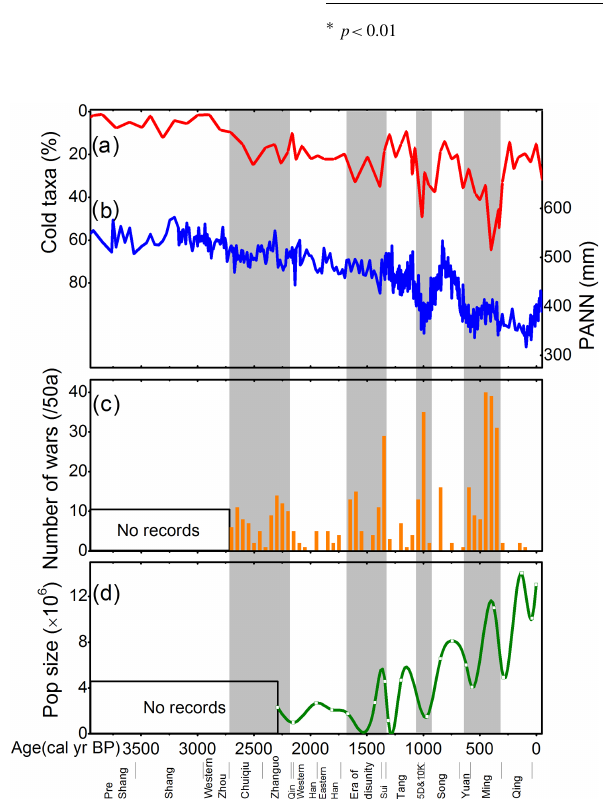
Figure 5. Comparison of (a) cold-preferring taxa percentages and (b) reconstructed precipitation at Gonghai Lake (Chen et al., 2015) with (c) frequencies of wars in Shanxi Province, China, and (d) pop- ulation size (in units of 1 million, square dots) of Shanxi Province during the past 2300 years; the data are spline connected. Grey shaded areas indicate cold